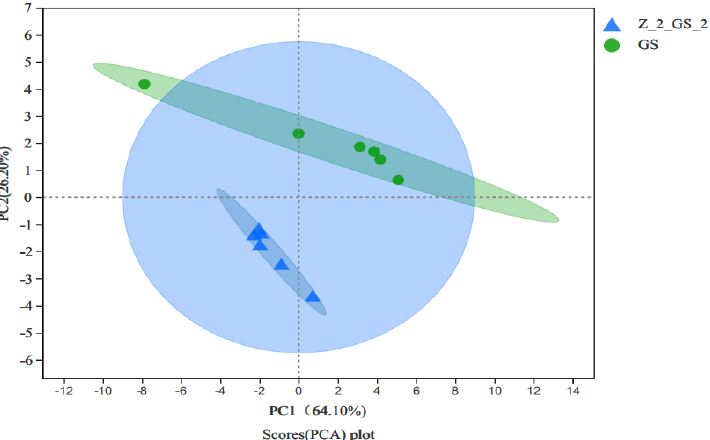
Figure 8. Targeted amino acid PCA score of GS and Z-2-GS-2 groups. Note: the GS group represents Vigna angularis without the spraying of FSA; the Z-2-GS-2 group represents Vigna angularis under FSA stress.